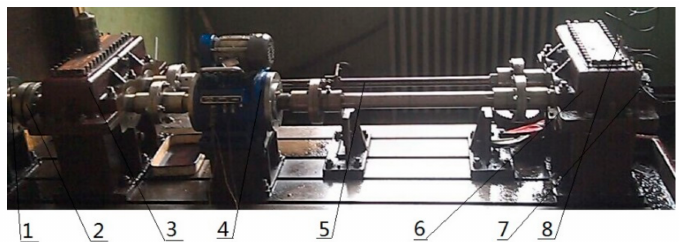
Figure 14. Rig for gear transmission testing. 1—Speed motor, 2—Coupling, 3—Accompanied gear box,